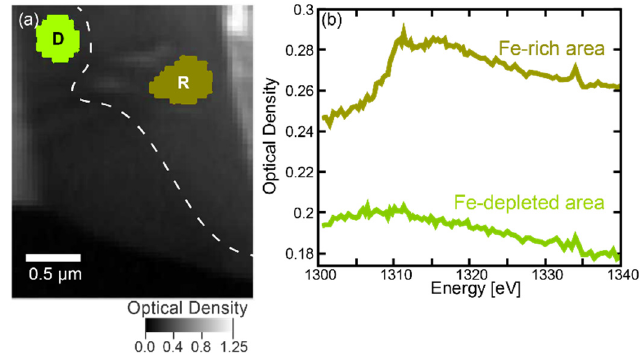
Figure A2. Results of XANES mapping by STXM around the Mg K-edge. ( a ) Raster scanned map at an X-ray energy of 1311.0 eV. Brighter colors represent higher optical densities. The white broken curves represent the approximate borders of the Fe-rich/depleted areas. The areas used for extracting the spectra are shown with the color of the index R (Fe-rich area) and D (Fe-depleted area). ( b ) The XANES spectra extracted from the Fe-rich/depleted area shown in panel ( a ).